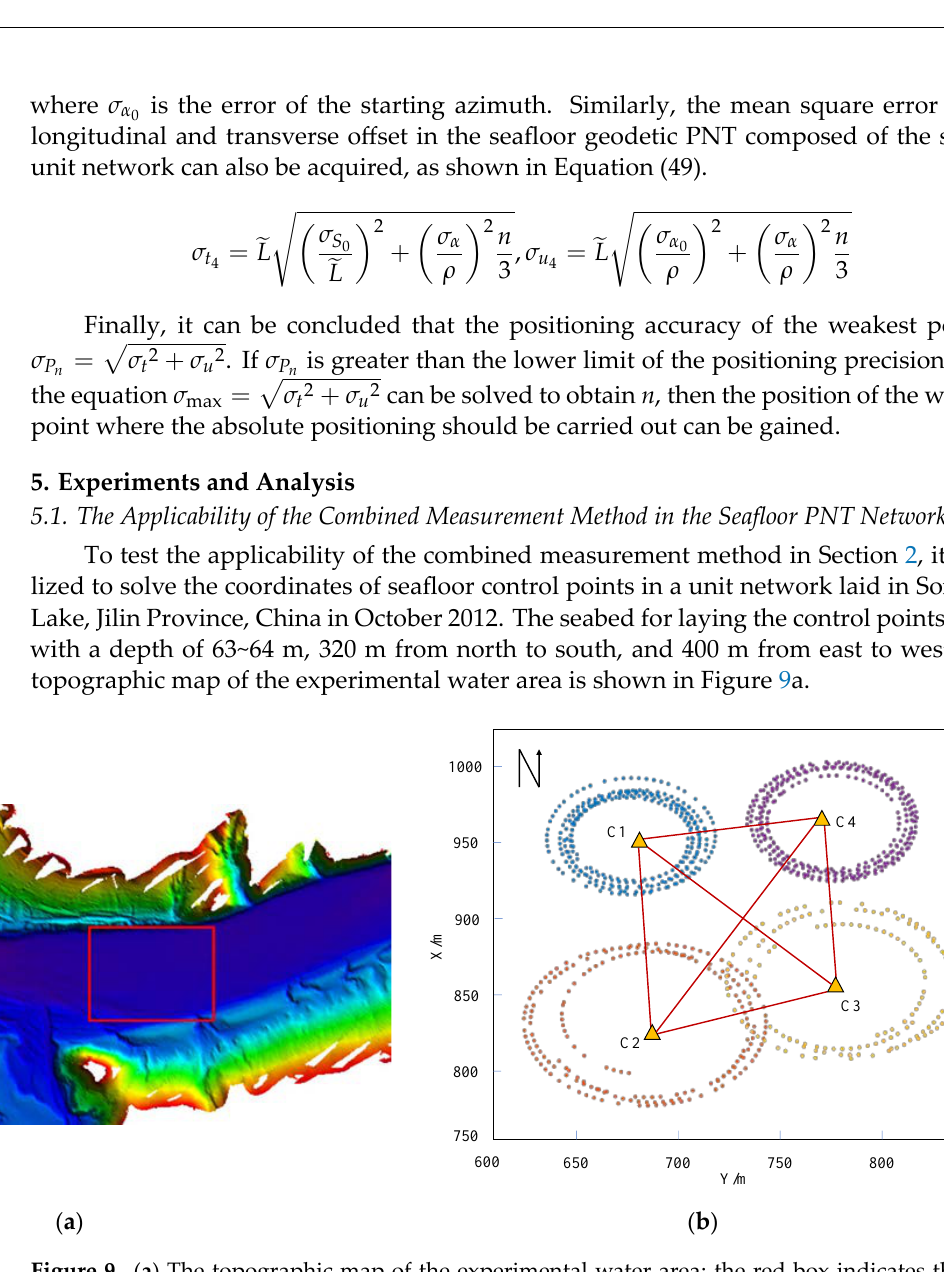
Figure 9. ( a ) The topographic map of the experimental water area; the red box indicates the area where the unit network is located (Reprinted with permission from Ref. [27]. 2022, John Wiley and Sons). ( b ) The structure of the unit network and trajectories of circle-sailing positioning.